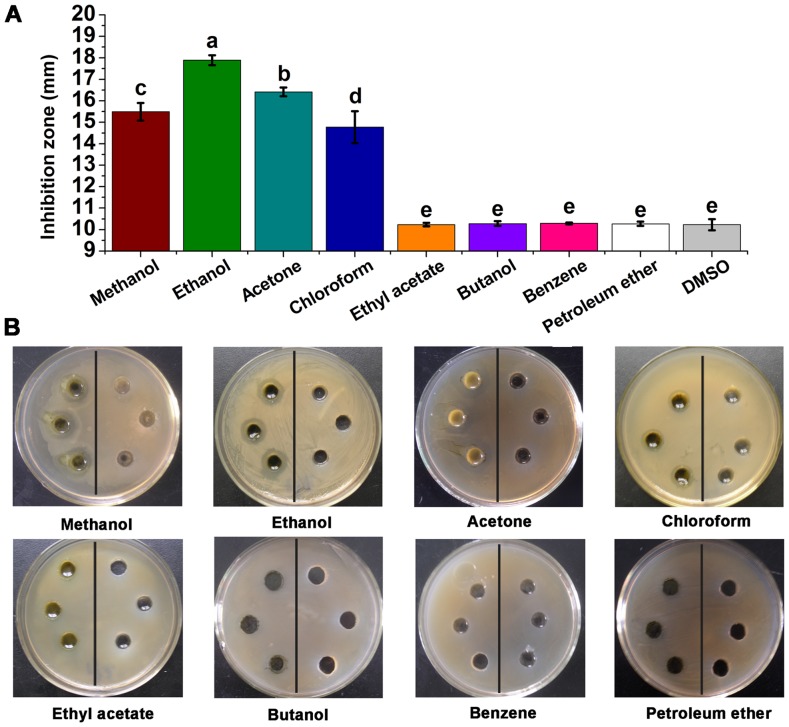
Antimicrobial activities of eight solvent extracts from L. japonica against C. michiganense subsp. sepedonicum.Tests (Figure 1A, B left). DMSO was used as the control (Figure1B right). A negative result is defined as an inhibition zone of 10 mm, while an inhibition zone of greater than 10 mm indicates a positive result. Different letters indicate significant differences (P<0.05; ANOVA and Duncan’s multiple range test). Bars represent the mean ± standard deviation. Each experiment was replicated four times.